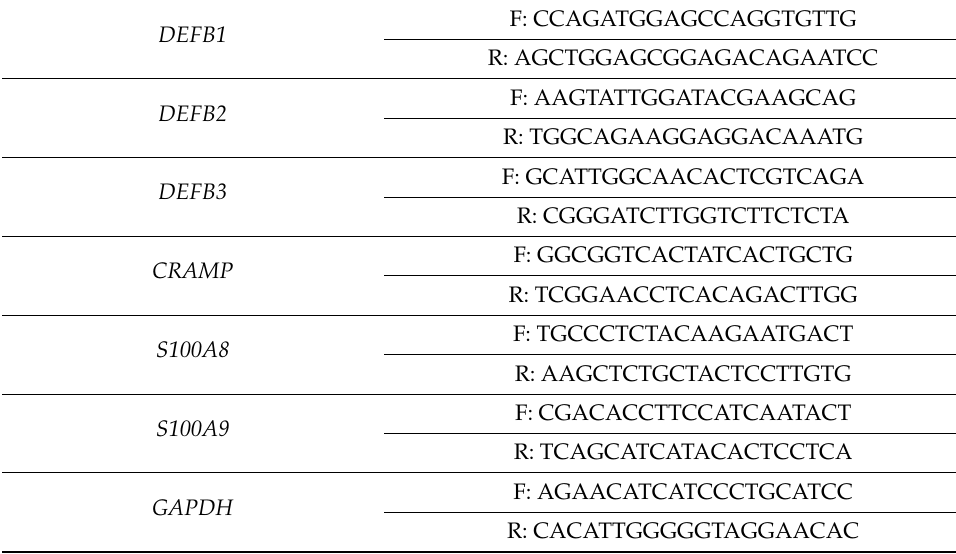
Table 1. The primer sequences used in this study (5 (cid:48) –3 (cid:48)